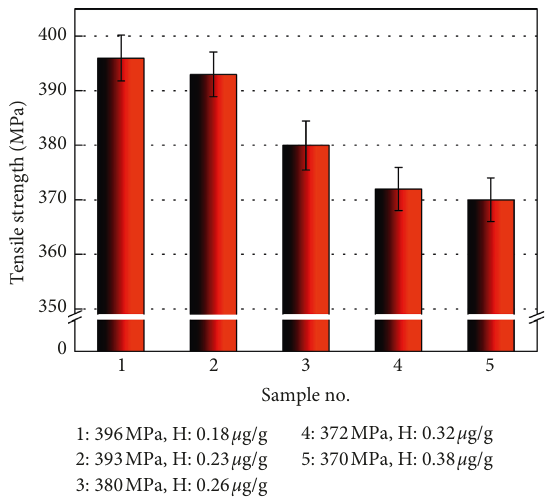
Figure 5: Tensile strength of the ϕ 5.2 mm